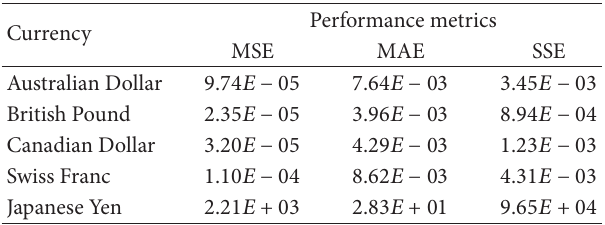
Table 4: Measurement of prediction performance over 60-day